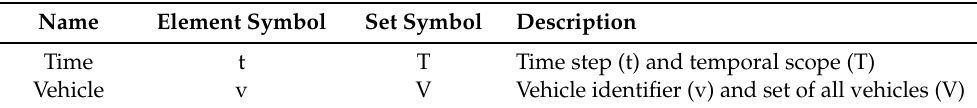
Table 1. Independent variables and respective algebraic